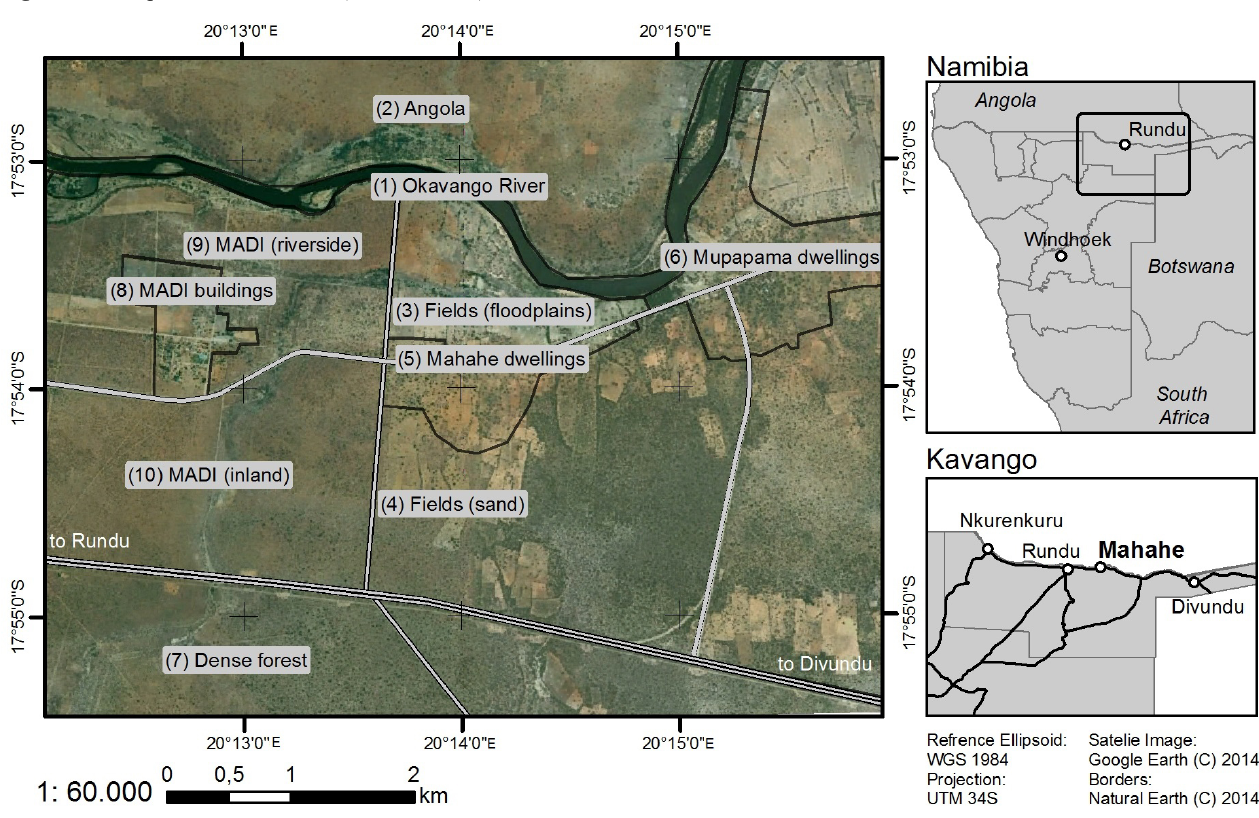
Fig. 1 . Landscape units of Mahahe (scale